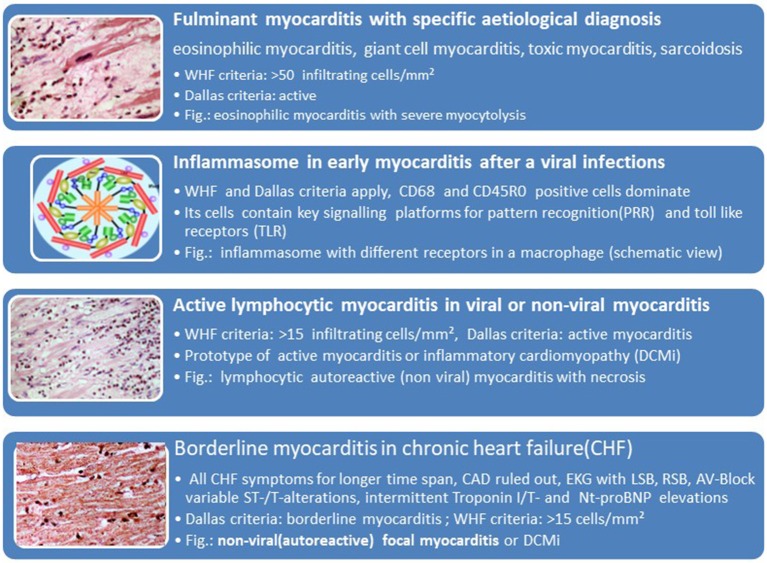
Histological phenotypes and components of myocarditis and inflammatory cardiomyopathy can correlate with clinical manifestations (faces).